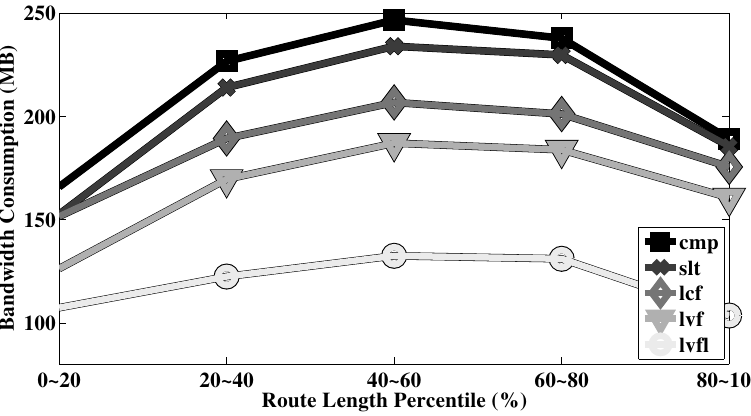
Figure 8. Varying length ranges of queries’ intended